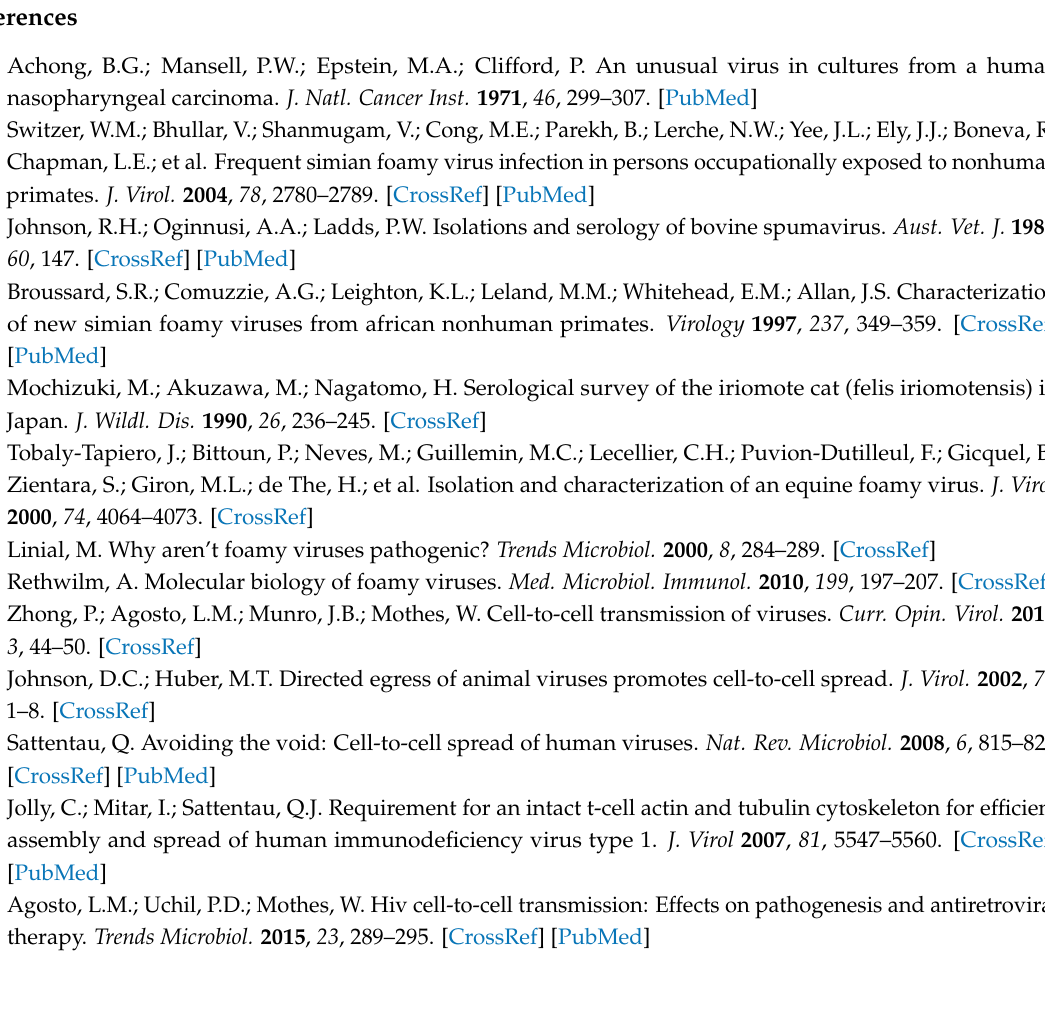
Table S1: The mutation amino acid (aa) sites in coding region of Cell-free BFV; Table S2: The mutation sites in noncoding region of Cell-free